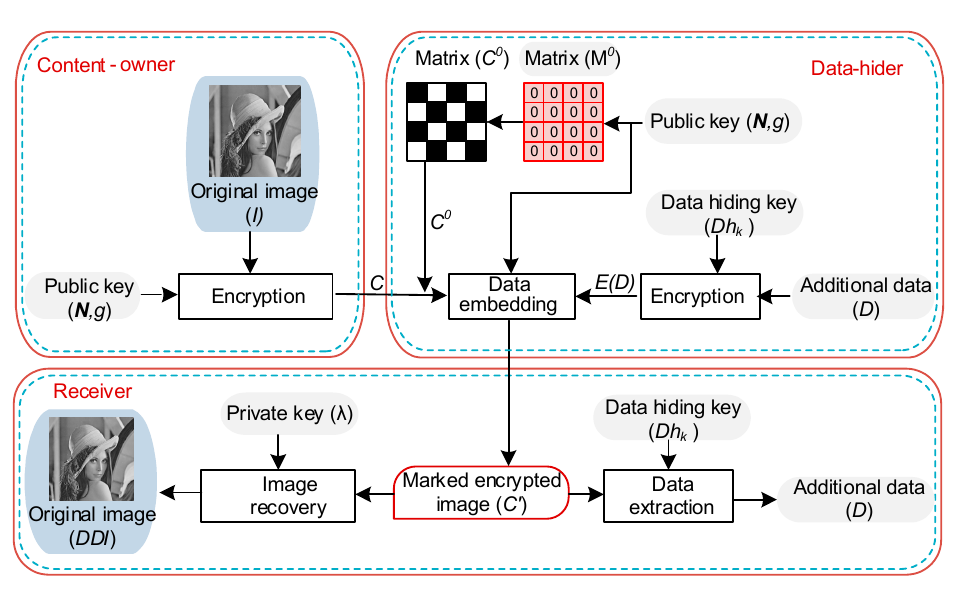
Figure 3. Working of the proposed scheme.